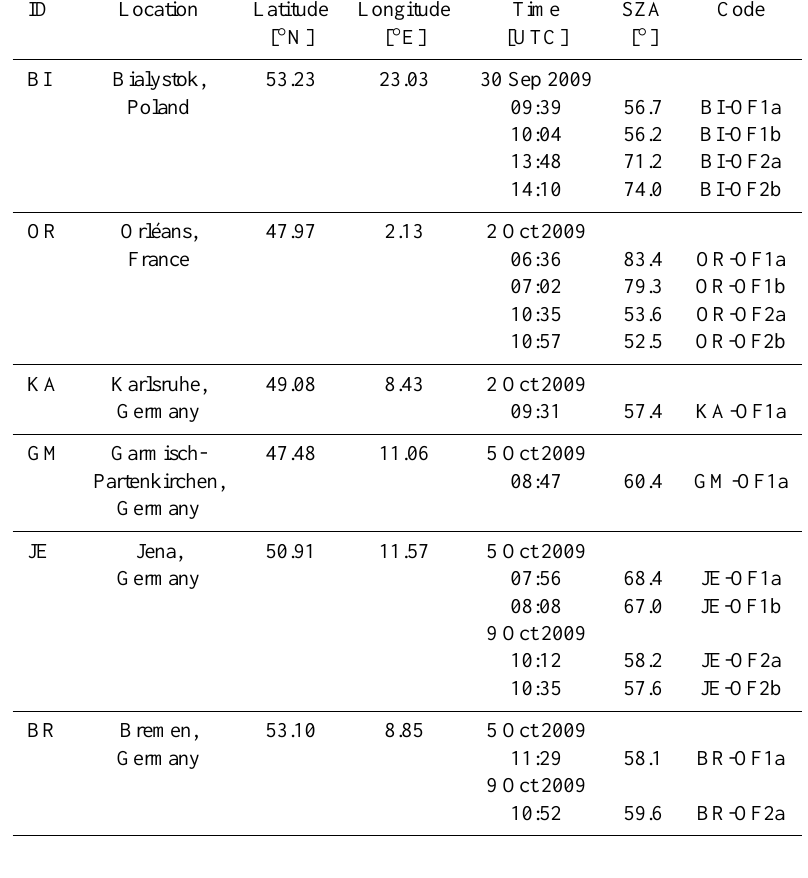
Table 1. The FTS stations of the IMECC campaign with the site IDs (as in Fig. 1), location, date and time of the overflight, solar zenith angle (SZA) during the overflight, and the profile code used throughout the text.